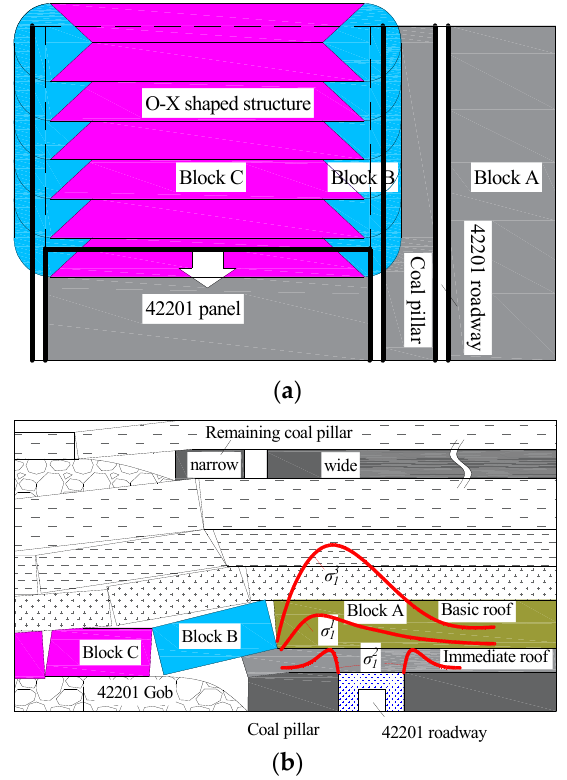
Figure 6. Roof fracture structure after mining at the working face. ( a ) Mining at the 42201 working face; ( b ) Gob-side entry retaining masonry beam structure.